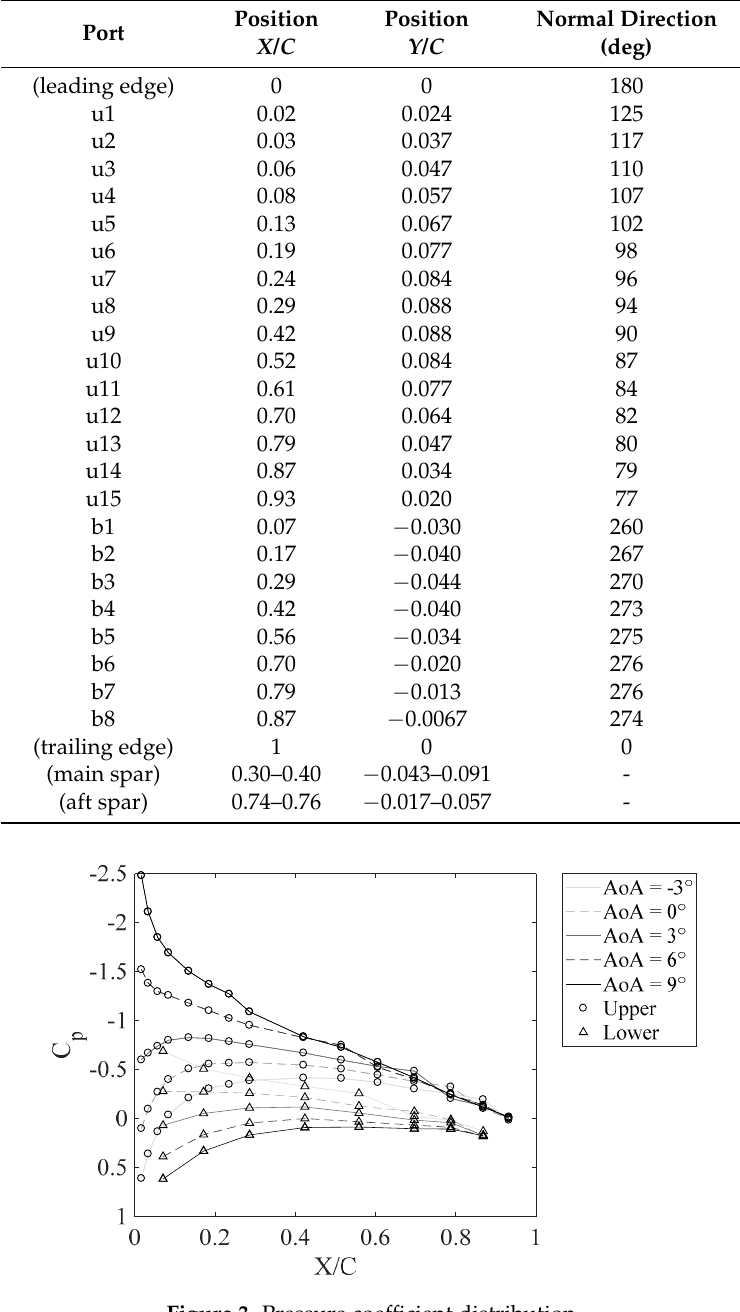
Figure 3. Pressure coefficient distribution.